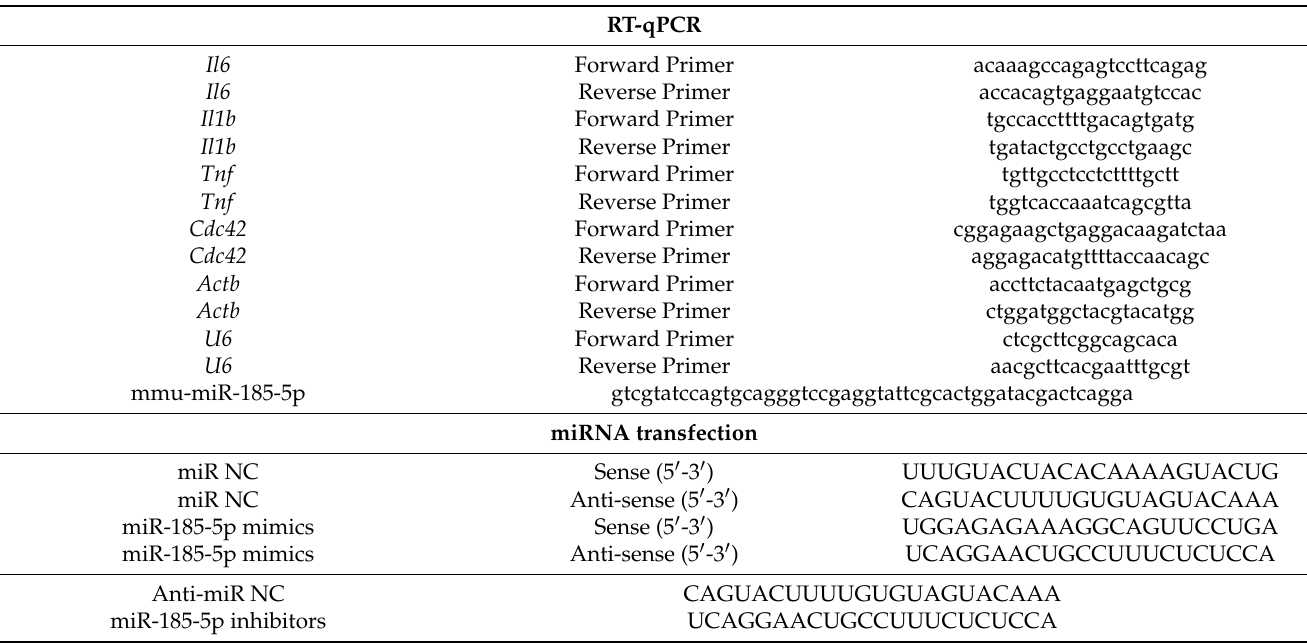
Table 2. List of sequences used in the